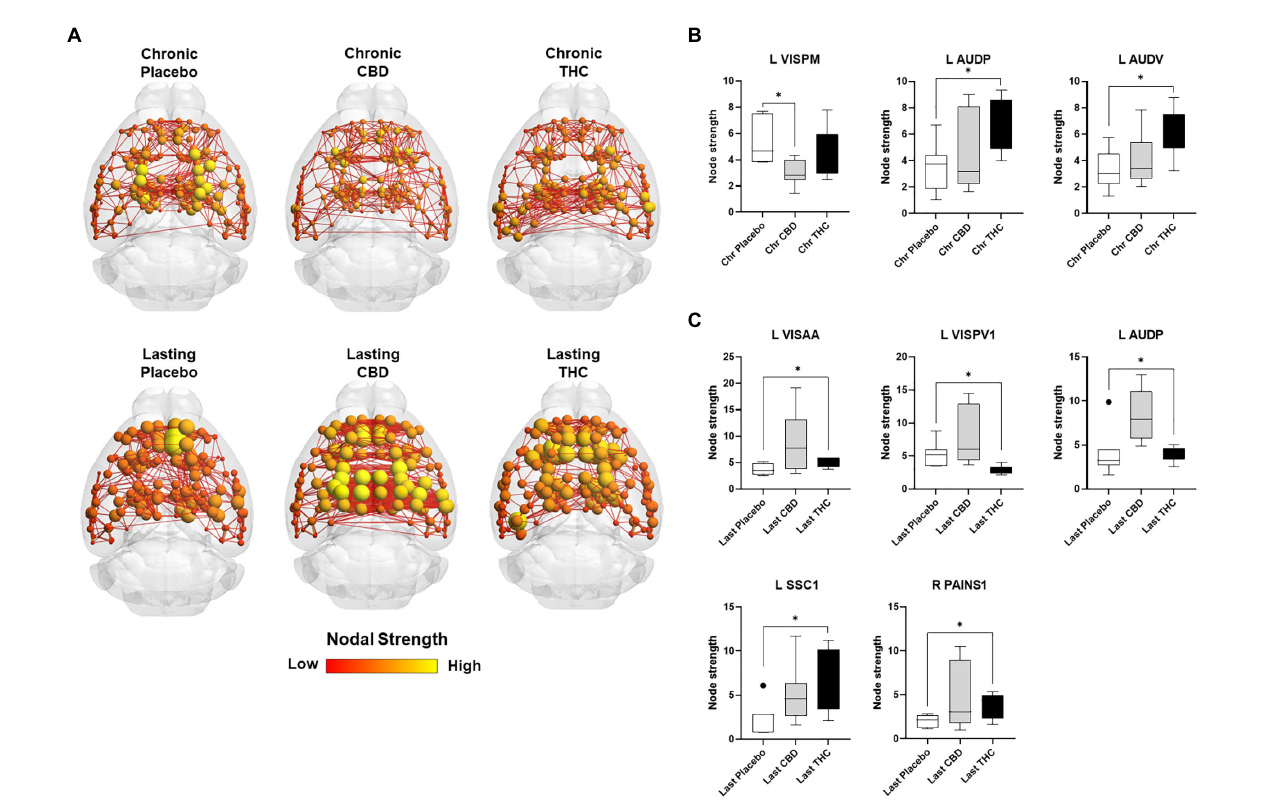
FIGURE 9 Regional differences in node strength. Regional differences in node strength following chronic placebo, CBD, or Δ 9-THC over 28 days (chronic) and after a 2-week washout period (lasting). (A) Connectome maps of a mouse functional network highlighting mean node strength across groups. Spheres represent scaled area under the curve (AUC) values for node strength calculated over several edge density thresholds (2–40%). Size and color intensity of spheres reflect high-to-low values (see scale bar). Lines between nodes represent pairwise connectivity between nodes (these are shown at edge density of 6% for visual clarity). (B) Node strength values for chronic treatment mice (calculated at a 16% edge density threshold). (C) Node strength values for post-washout period (calculated at a 16% edge density threshold). Data are shown as mean ± standard error ( t -test, FDR q = 0.05, p < 0.01). Abbreviations: L VISPM, left posteromedial visual cortex; L AUDP, left posterior auditory cortex; L AUDV, left ventral auditory cortex; L VISAA, left anterior area of the visual cortex; L VISPV1, left ventroposterior visual cortex node 1; L SCC1, primary somatosensory cortex; R PAINS1, right posterior agranular insula node